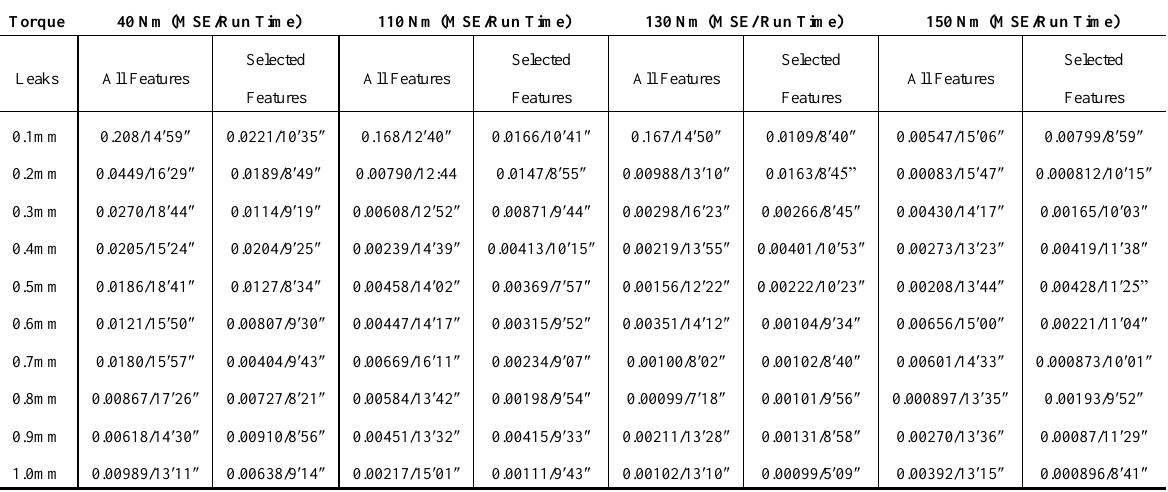
Table 1. Mean Squared Error (MSE) Evolution with torque